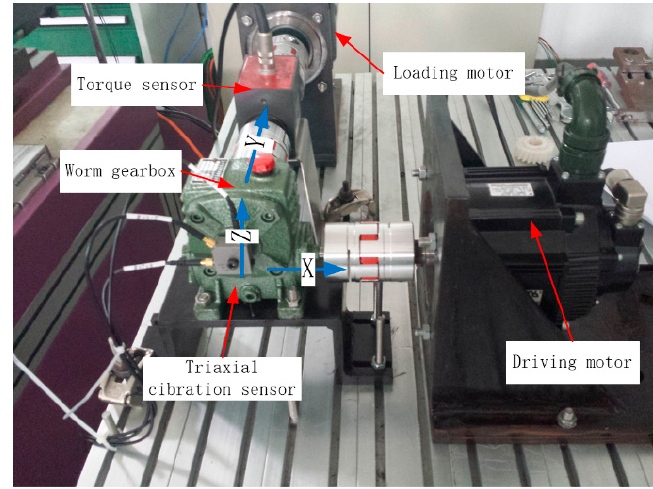
Figure 12. Comparison of different methods.